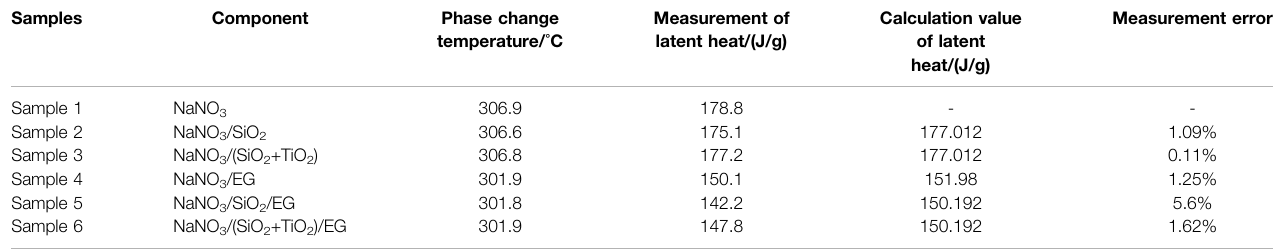
TABLE 4 | Phase change temperature and latent heat value of different samples.